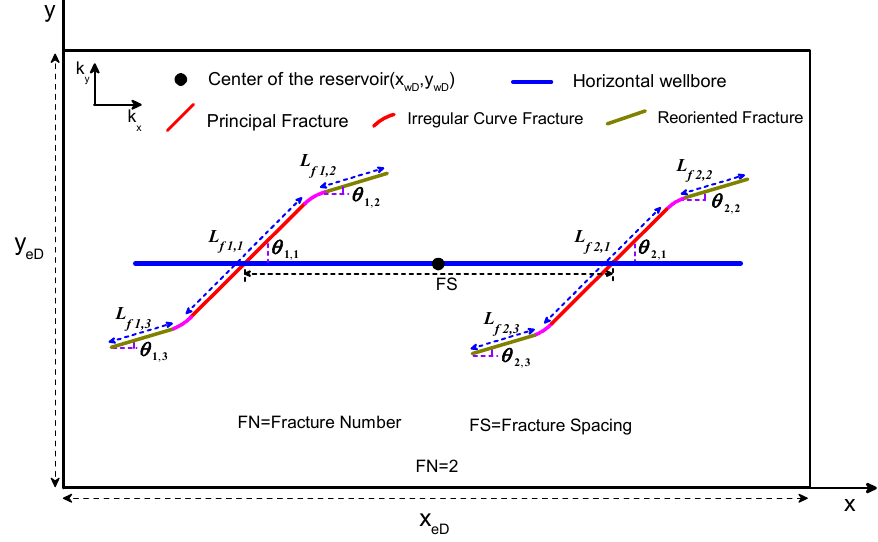
Figure 1. Schematic of two reorientation fractures along a horizontal well.